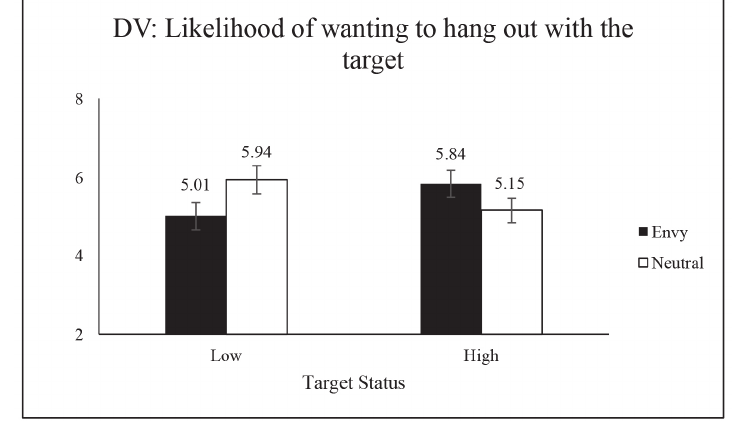
<Figure 1> Likelihood of wanting to hang out with the target in the future (experiment 1). The error bars are based on the 95% confidence